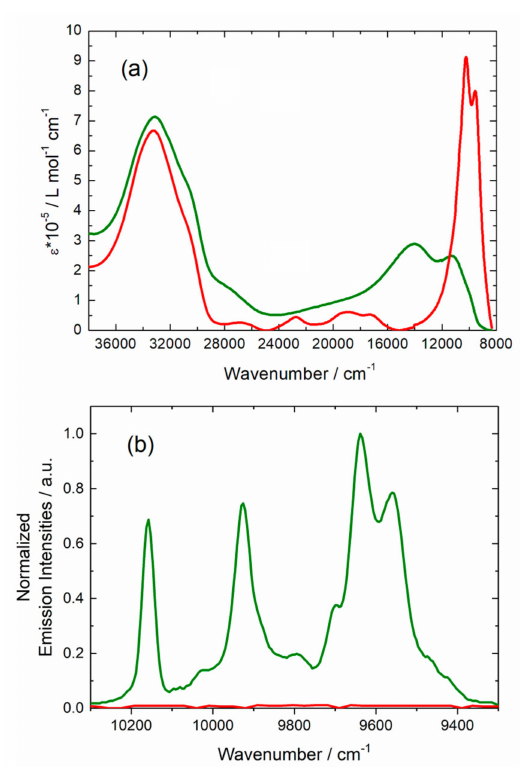
Figure 6. ( a ) Experimental UV-visible absorption spectra at room temperature of H 2 SQ-Yb (green line) and Q-Yb (red line) in CH 2 Cl 2 solution (C = 4 × 10 − 5 mol.L − 1 ). ( b ) Emission spectra at 77 K of H 2 SQ-Yb (green line) and Q-Yb (red line) for an irradiation energy of 16670 cm − 1 in solid-state. The e ffi ciency of the NIR emission sensitization strongly depends on the energy position of the − 1 ILCT. The donating ILCT (S → L in Scheme 2) in H 2 SQ-Yb is localized 2300 cm above the emitting ffi cient sensitization while both donating and emitting levels 2 F 5 / 2 level which is well suited for an e are localized at the same energy in Q-Yb leading to e ffi cient back energy transfer (BET) and thus a quenching of the NIR emission.